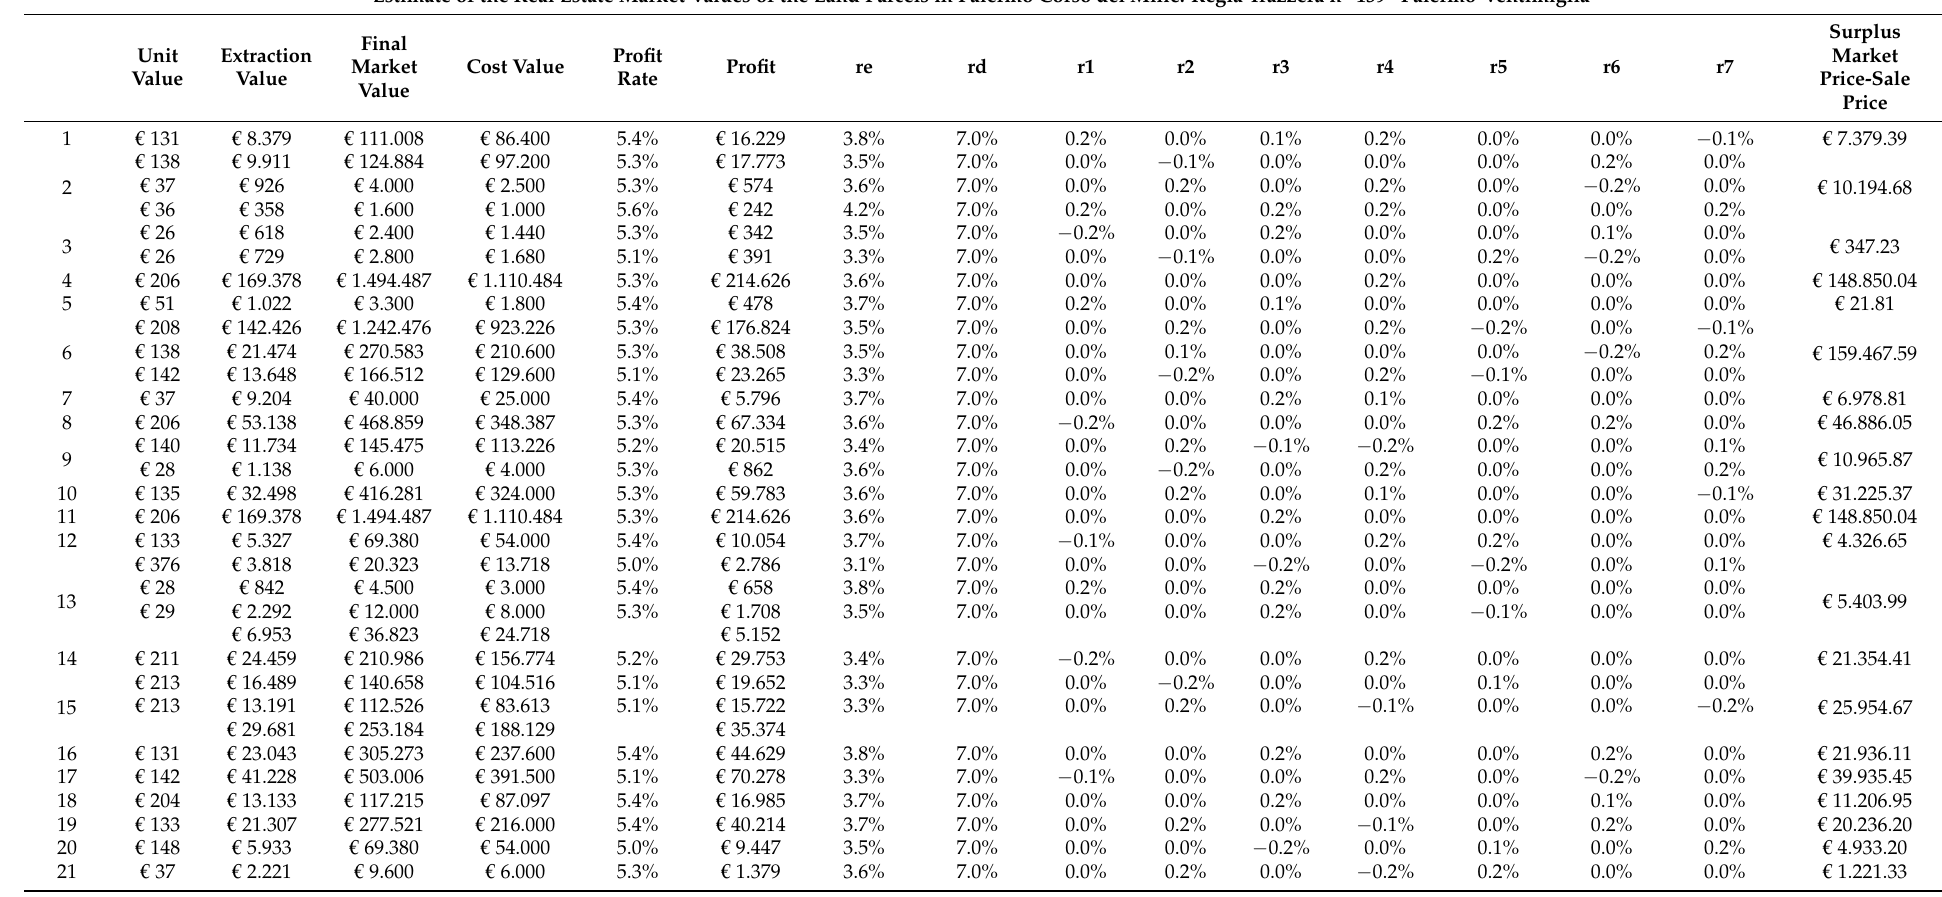
Table 4. Residual value of the land parcels in the sample urban area of Corso dei Mille in Palermo and the calculation of the difference (surplus) between market value and sale